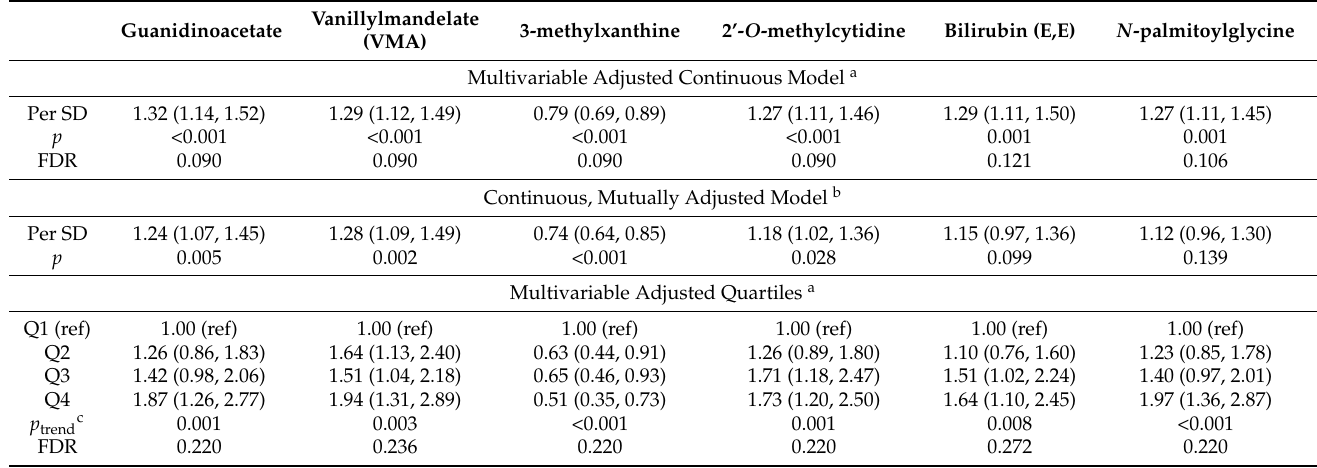
Table 2. OR and 95% CI for metabolites associated with colorectal cancer risk at FDR < 0.2 in the Cancer Prevention Study II Nutrition Cohort ( n = 517 matched cases and controls).